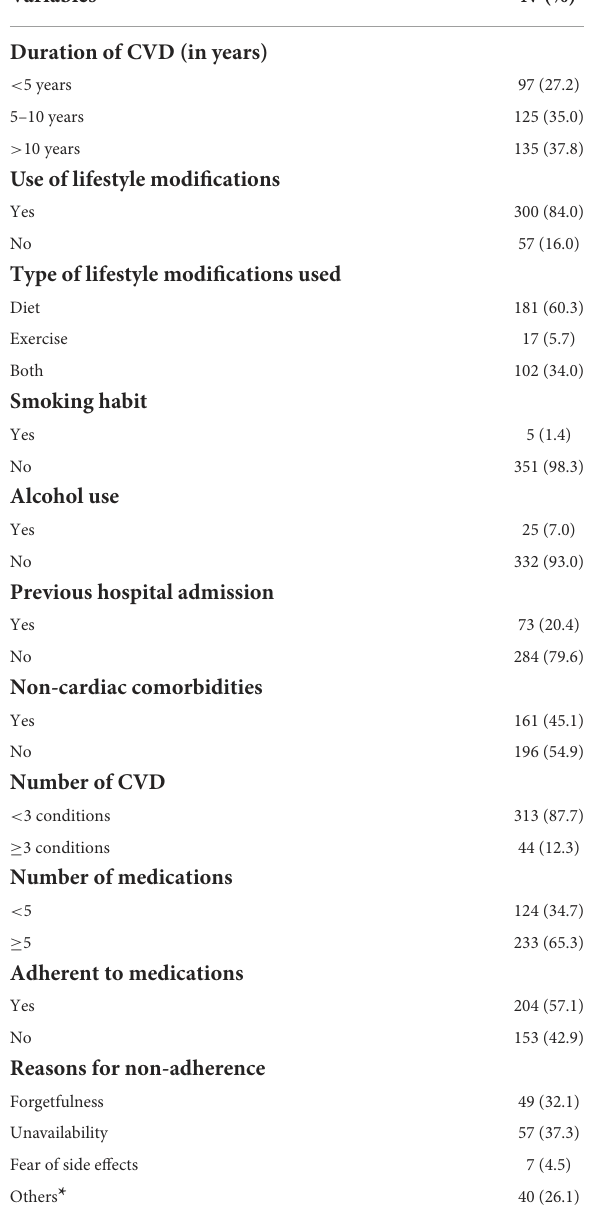
TABLE 2 Clinical characteristics of patients with cardiovascular